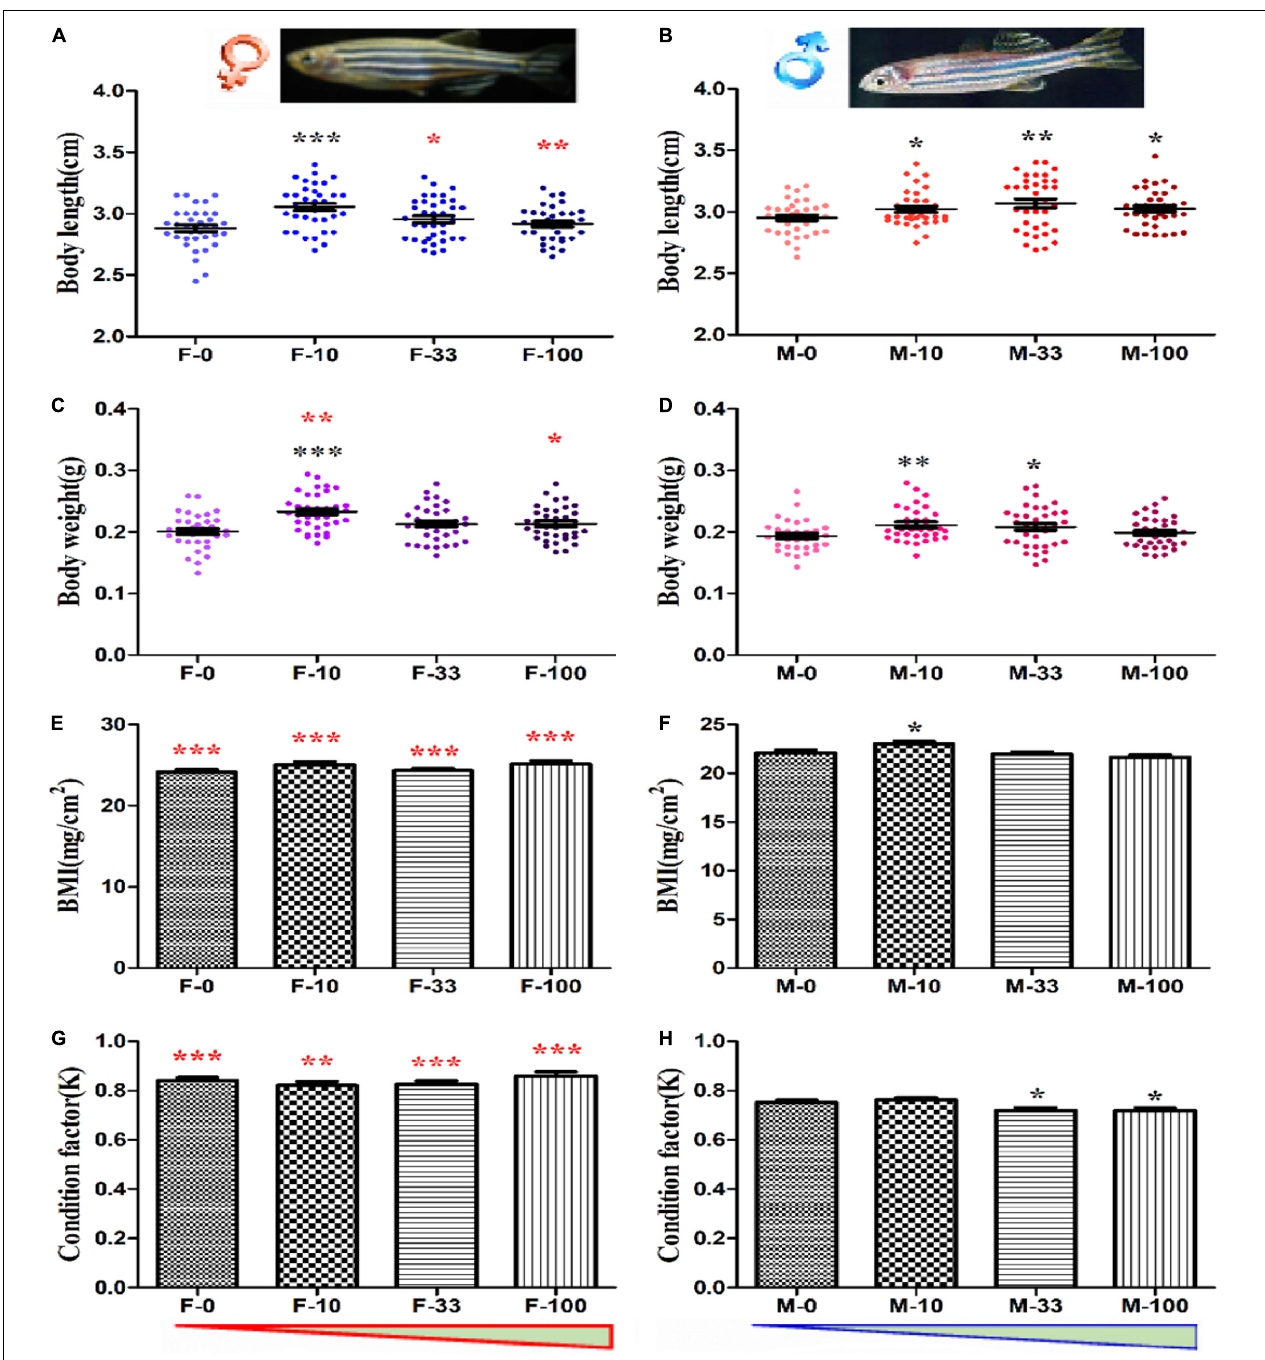
FIGURE 1 | The developmental indexes of zebrafish after long-term DEHP exposure. The body length (cm) of female (A) and male (B) fish, and the body weight (g) of female (C) and male (D) fish were presented. The BMI and condition factor (K) of female (E,G) and male (F,H) fish were calculated. The data were presented as the mean ± standard error (SEM) of (12 pairs recorded/replicate, 3 biological replicates/group, n = 36 female and 36 male) zebrafish in each group. The black symbols *, **, and *** showed p < 0.05, 0.01, and 0.001 with significant differences between exposure and control groups (F-0 vs. F-10, F-0 vs. F-33, F-0 vs. F-100, M-0 vs. M-10, M-0 vs. M-33, and M-0 vs. M-100), and the red symbol *, **, and *** stands for the significances between female and male in the same groups (F-0 vs. M-0, F-10 vs. M-10, F-33 vs. M-33, and F-100 vs. M-100). The red and blue triangles are represented for the concentration trend of DEHP exposure in female and male